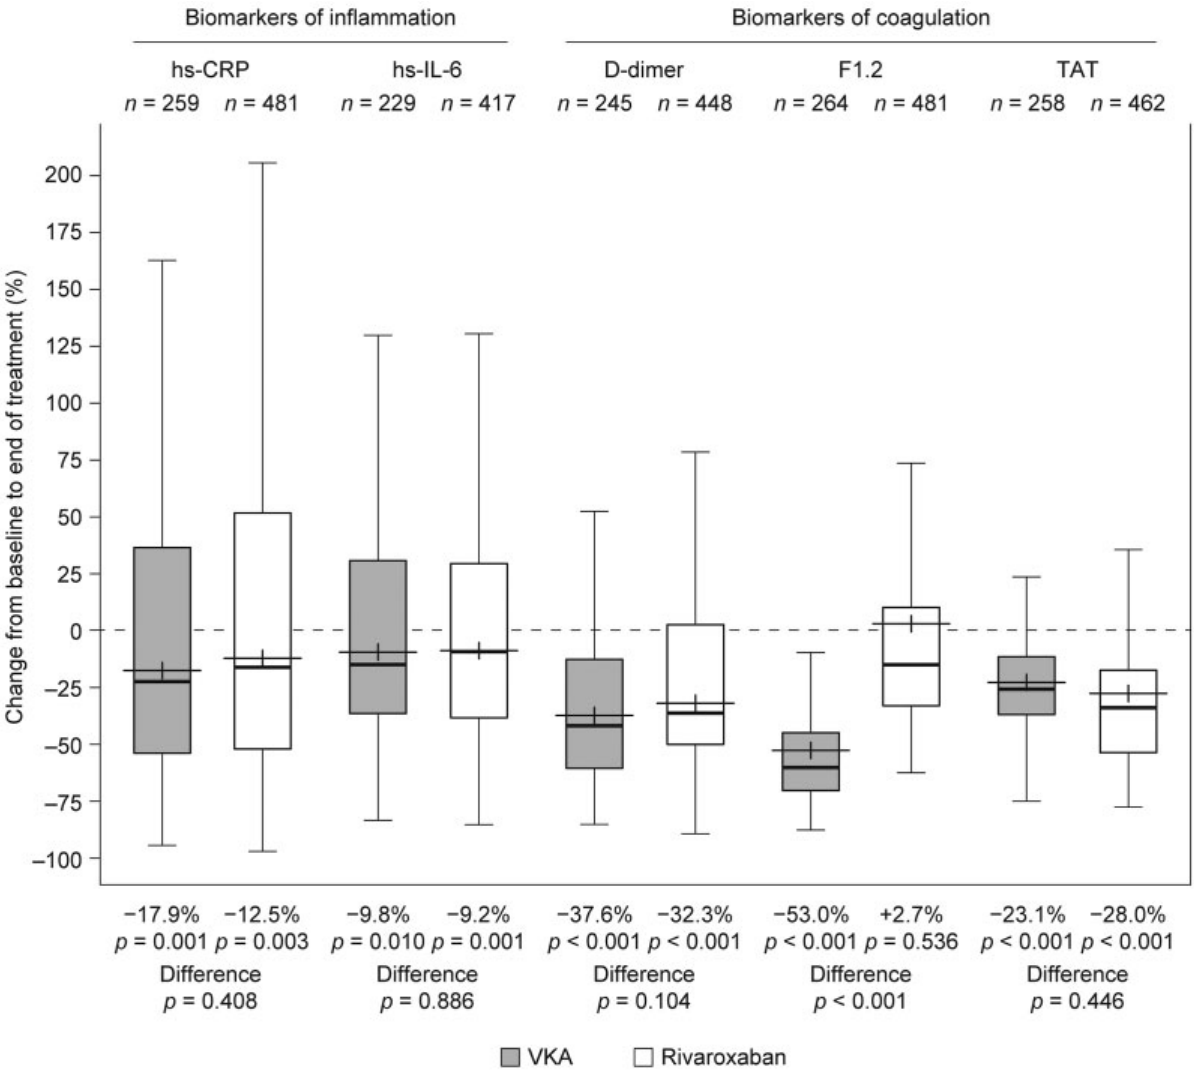
Fig. 5 Relative changes of biomarker levels from baseline to the end of treatment, model-adjusted for biomarker baseline level, and treatment duration. F1.2, prothrombin fragment 1 þ 2; hs-CRP, high-sensitivity C-reactive protein; hs-IL-6, high-sensitivity interleukin-6; TAT, thrombin – anti-thrombin III complex; VKA, vitamin-K antagonist. Note: Upper lines of the box denote the upper quartiles, mid-lines denote the medians and lower lines denote the lower quartiles; crosses denote the geometric means, and upper and lower lines denote maximum and minimum values, excluding outliers (i.e., values that are > 1.5 times the interquartile range further apart from the